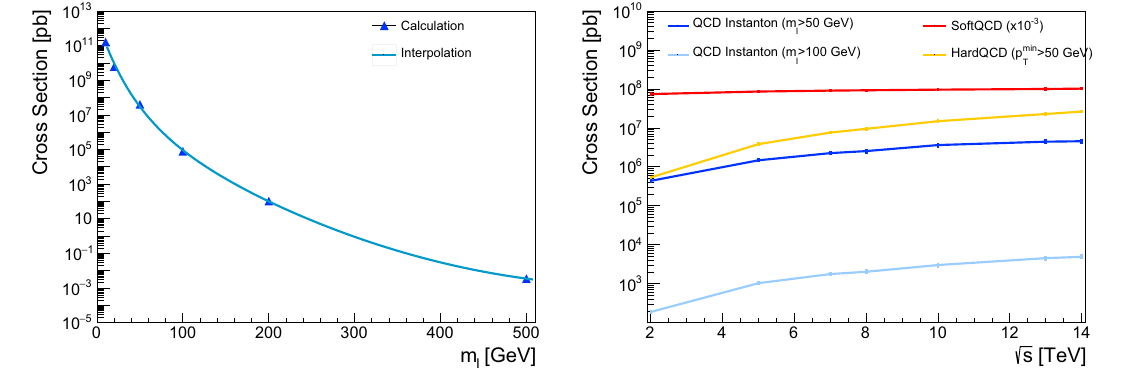
√ s = 13 TeV as a function of their mass (left) and a √ s between the Instanton signal and various background processes (right)